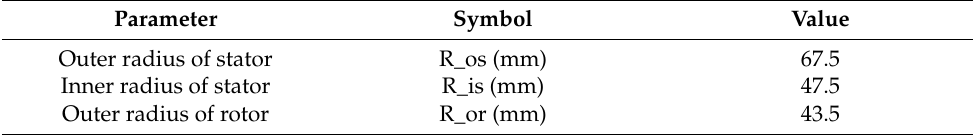
Table 2. Variable parameters of the PMSM.